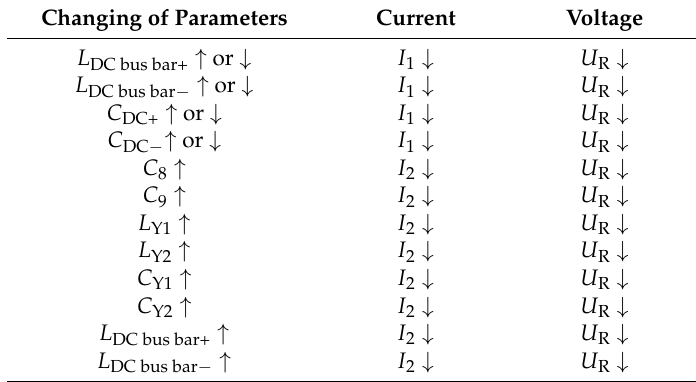
Table 3. The effect of the main distribution parameter on conducted EMI emission.